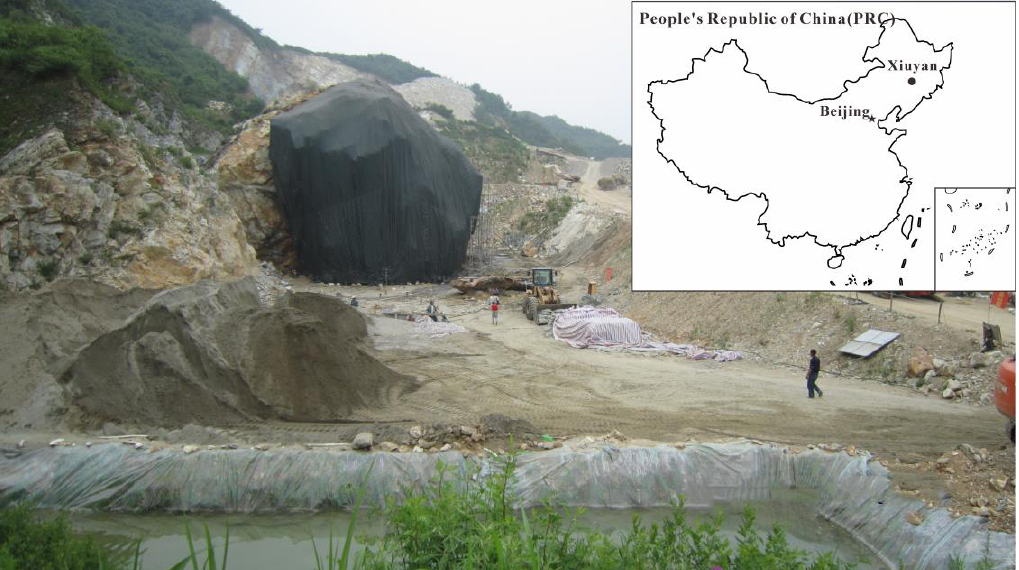
Figure 7. Field survey site scene and it location map in China. The giant jade is at the center of the photo.